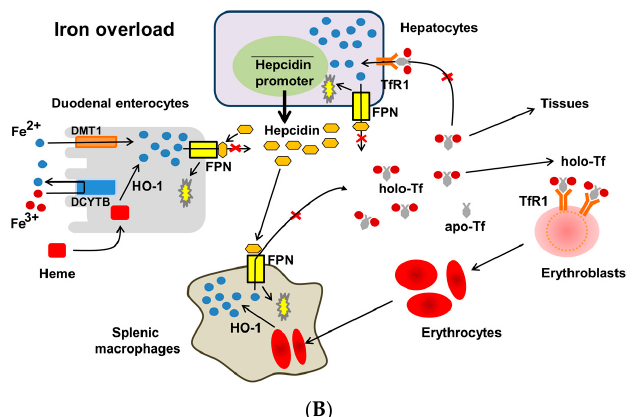
Figure 1. Regulation of systemic iron homeostasis. Divalent metal transporter 1 (DMT1) at the apical membrane of enterocytes takes up Fe 2+ from the lumen after duodenal cytochrome b (DCYTB) reduces dietary Fe 3+ to Fe 2+ . Ferroportin (FPN) at the basolateral membrane exports Fe 2+ into the circulation. FPN cooperates with hephaestin that oxidizes Fe 2+ to Fe 3+ . In hepatocytes and macrophages, Fe 2+ is oxidized by a ferroxidase, ceruloplasmin (CP). Diferric iron (Fe 3+2 )-transferrin (holo-Tf) supplies iron to all cells and tissues through binding to Tf receptor 1 (TfR1) and endocytosis. Erythrocytes are phagocytized by macrophages. Hemoglobin-derived heme in enterocytes and macrophages is catabolized by heme oxygenase-1 (HO-1). After sensing iron, hepatocytes produce and release hepcidin. In iron deficiency ( A ), low hepcidin facilitates iron export by FPN into the circulation. In iron overload ( B ), high hepcidin binds to FPN and inhibits iron export from enterocytes, hepatocytes and macrophages by triggering internalization and degradation of FPN, leading to reduction of iron storage. Dashed line indicates less iron supply. x: inhibition. Figures adapted from [12].